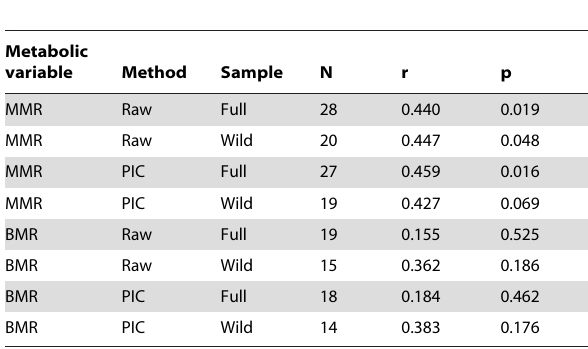
Table 2. Relationship between residual brain mass and residual metabolic rate.